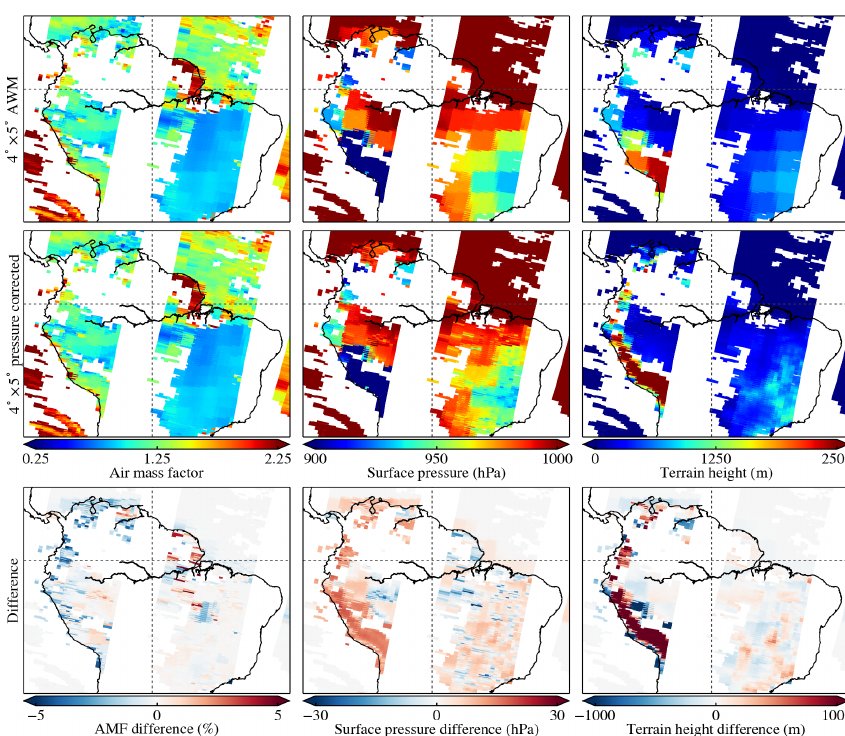
Figure 6. GOME-2 orbital tracks over the Amazon showing the effect of the Zhou et al. (2009) pressure correction (Sect. 5.4) against a fully area-weighted set of GEOS-Chem 4 ◦ × 5 ◦ inputs (Sect. 5.3). Left to right: the first two rows (area weighted mean only inputs, and pressure-corrected AWM inputs on the second) show AMF, model surface pressure and terrain height; the bottom row details difference between these parameters for both cases. Differences between the two tests are exclusively due to the pressure correction alone. As such, the correction is most noticeable over mountainous terrain, causing AMF differences of about ±